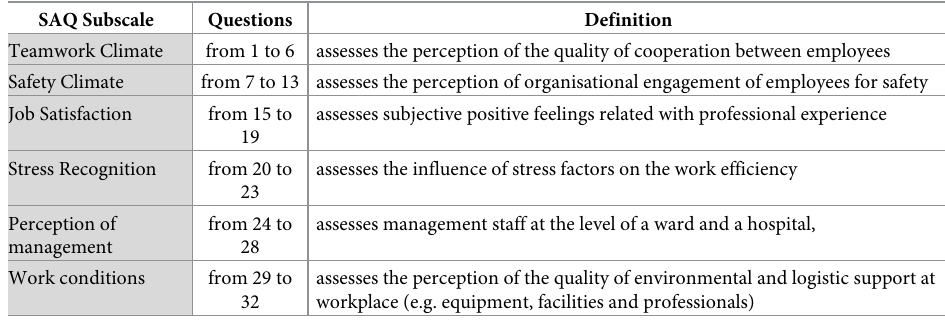
Table 1. SAQ subscale and